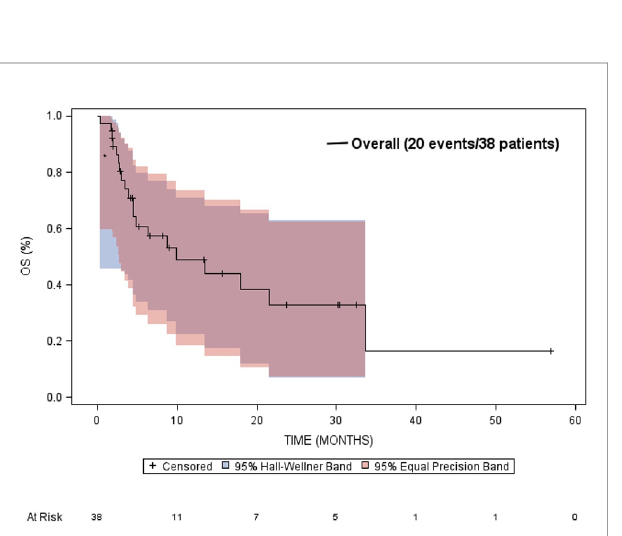
FIGURE 4 | Overall response rate of patients who received targeted treatment at different time points.